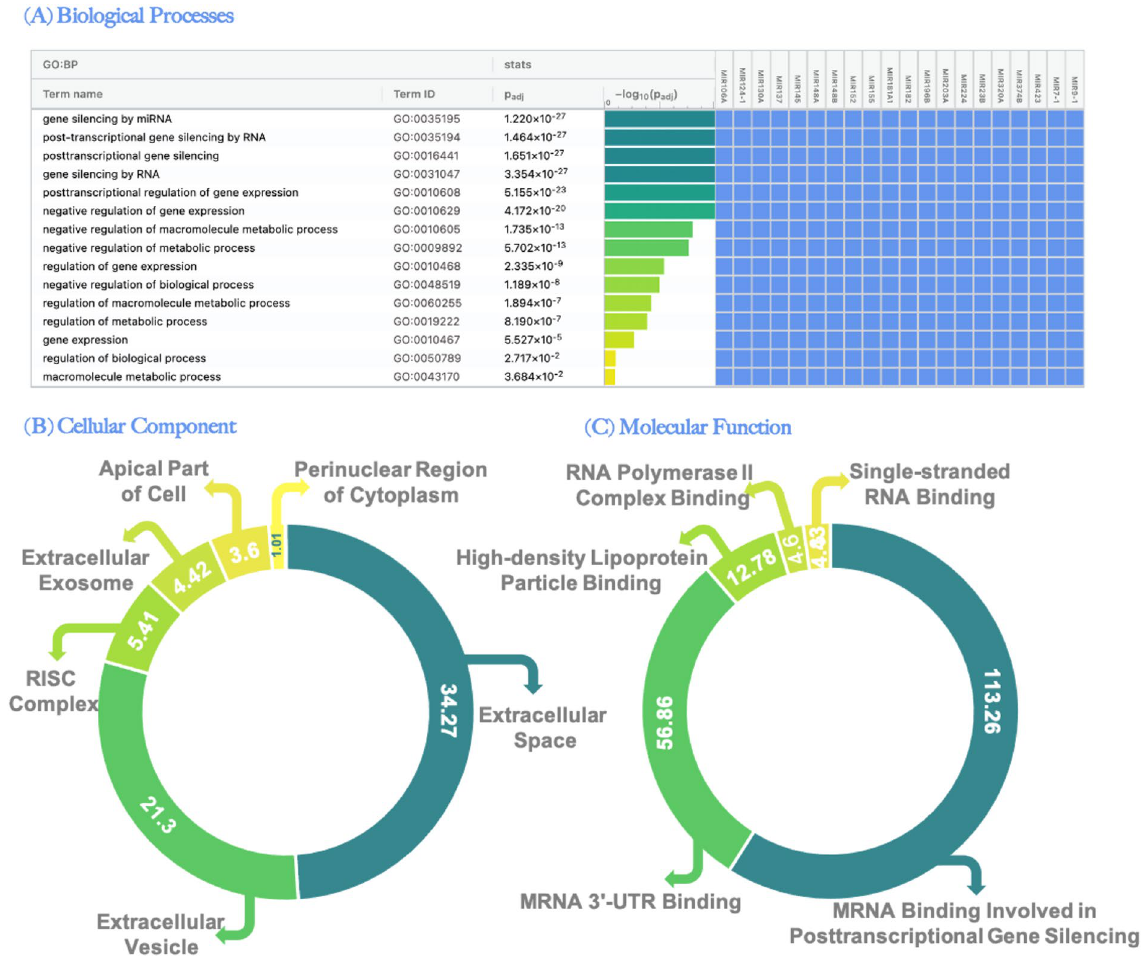
Figure 4. The gene ontology (GO) for the 20 circulating miRNAs under study. ( A ) Biological processes in descending order according to score detected using (http:// biit. cs. ut. ee/ gprofi ler/ gost) ( B ) Cellular component according to matching score detected using (https:// genea nalyt ics. genec ards. org) ( C ) Molecular function according to matching score detected using (https:// genea nalyt ics. genec ards.